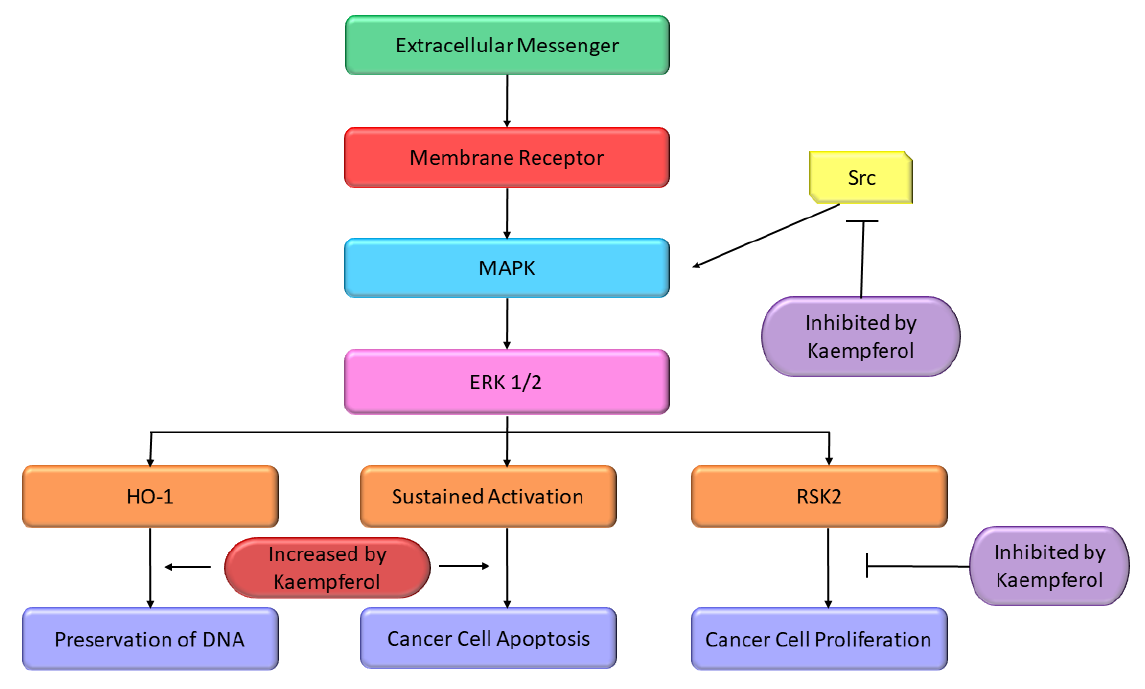
Figure 4. Effect of Kmp on MAPK pathway